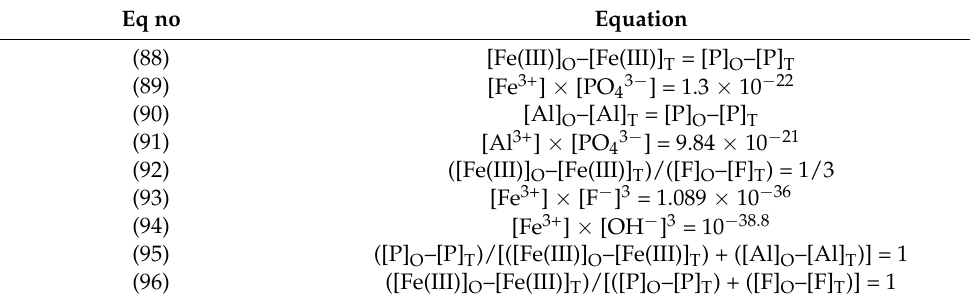
Table 7. Constraint equations for different solid phase stable region.